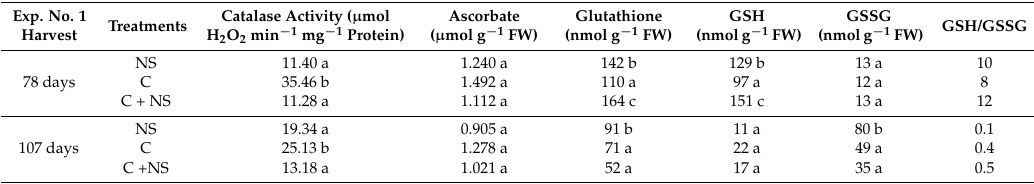
1 Data based on dry weight. Note: Data represent the mean of eight independent replicates. For each nutrient, harvest and plants organ, values followed by the same lower-case letter among treatments (NS, C and C + NS, respectively) are not statistically different according to one-way ANOVA with Tukey–Kramer post-hoc test at p < 0.05. T OC : total organic carbon. T N : total nitrogen. Table 4. Catalase activity, ascorbate, glutathione, reduced (GSH) and oxidized glutathione (GSSG) contents determined in pepper leaves of Exp. No. 1 according to treatments assayed. Data were collected from the onset of flowering (78 days) until fruit harvesting (107 days). NS, plants grown with full nutrient solution; C, plants only grown with compost; C + NS, plants grown with compost and complemented with full nutrient